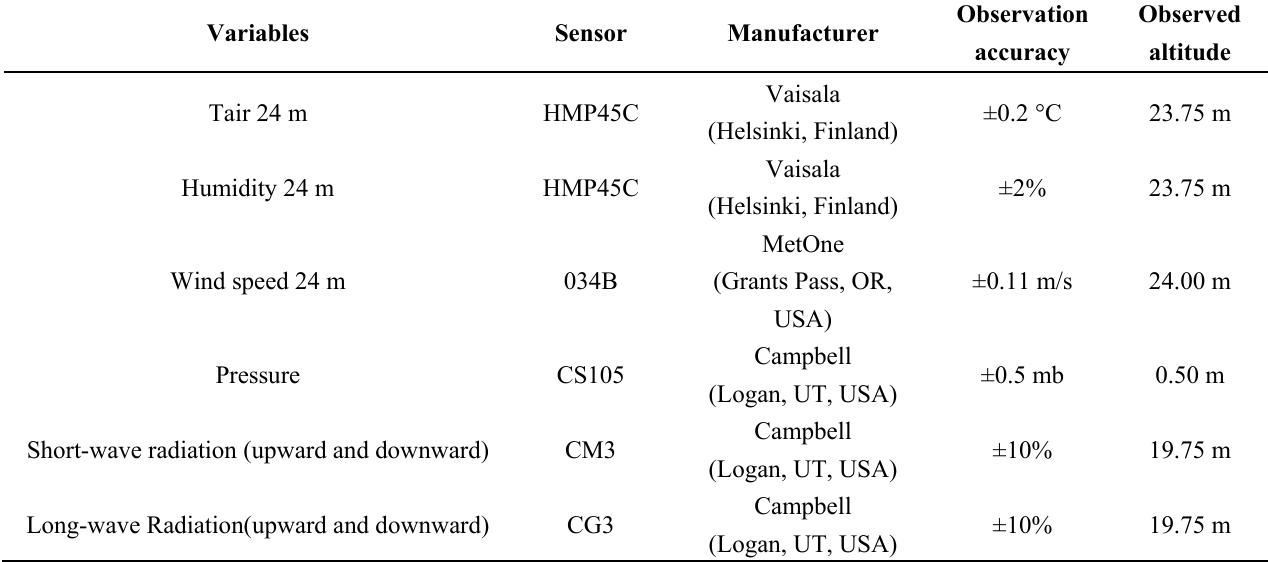
Automatic Weather Station (AWS) at the Dayakou forest hydrology experimental site. Variables Sensor Manufacturer Tair 24 m HMP45C Humidity 24 m HMP45C Wind speed 24 m 034B Pressure CS105 Short-wave radiation (upward and downward) CM3 Long-wave Radiation(upward and downward) CG3